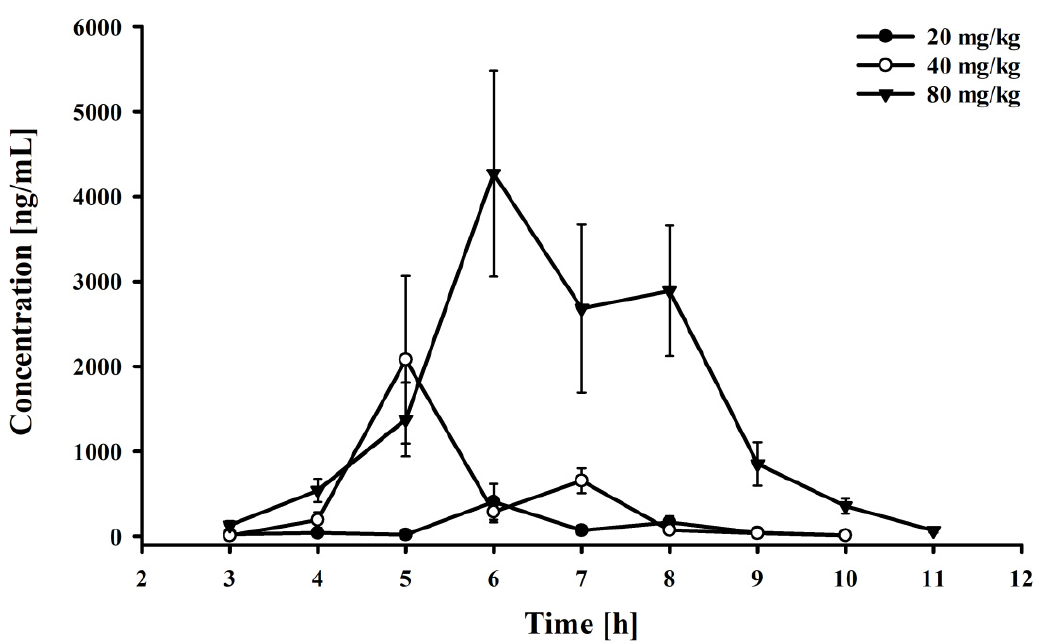
Figure 2. Plasma-concentration–time profile of 4-acetamidobenzoic acid after oral administration to pigs at a different doses. Table 5. Pharmacokinetic parameters (noncompartmental analysis) of 4-acetamidobenzoic acid in pigs after oral administration at different doses.